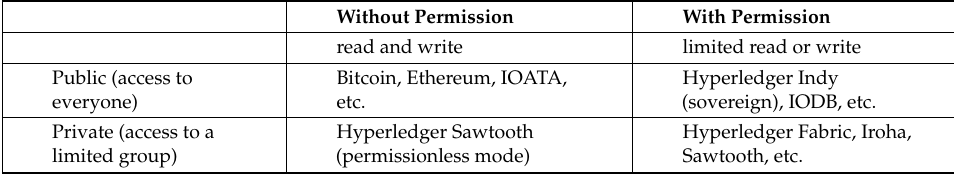
Table 2. Blockchain Types.